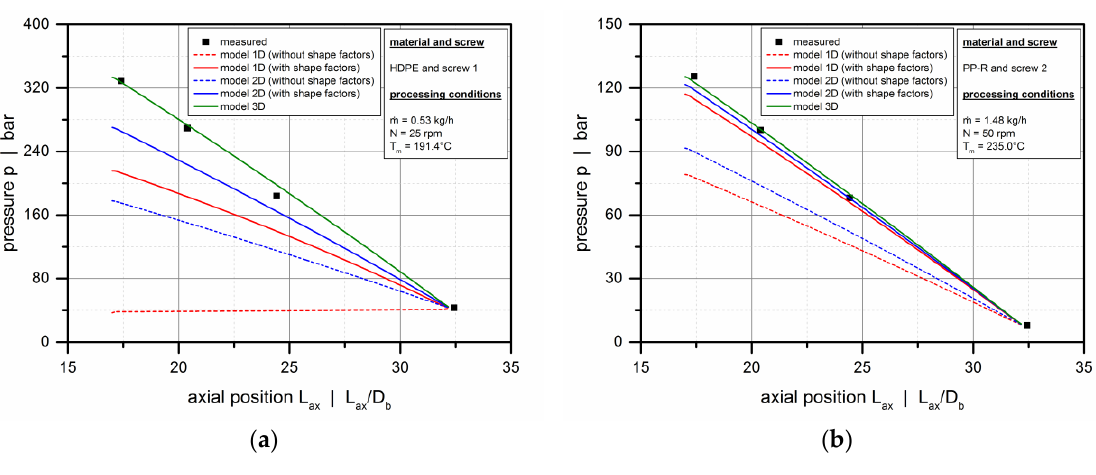
Figure 11. Influence of the screw flights. Comparison between experimental data and solutions from model 1D, model 2D, and model 3D. Axial pressure profiles for various experimental setups: HDPE, screw 1, N = 25 rpm ( a ); PP-R, screw 2, N = 50 rpm ( b